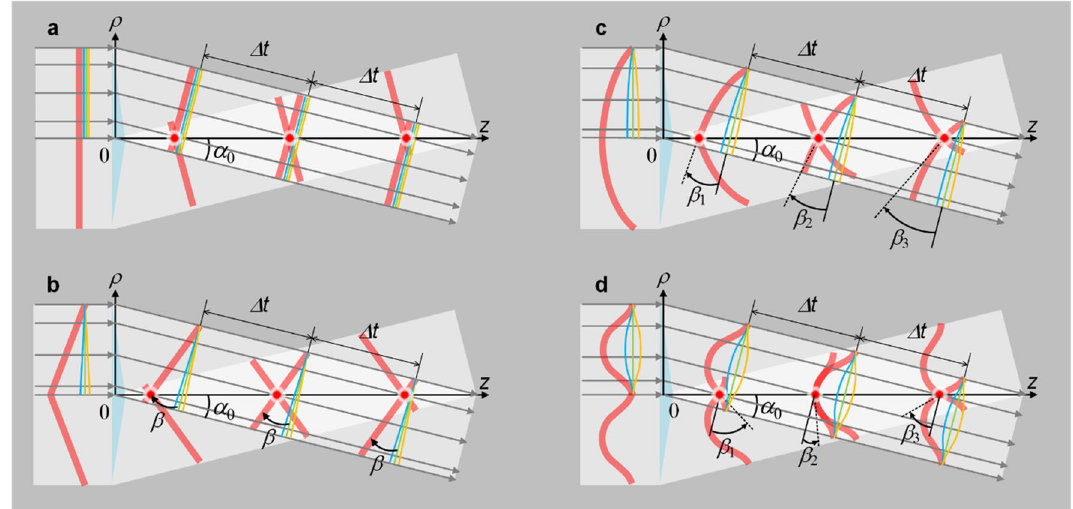
Figure 3. Influence of pulse-front deformation of input pulsed beam on instantaneous group-velocity of produced propagation-invariant optical wave-packet. Because distribution is axisymmetric about z -axis, only upper input half beam for conical superposition is illustrated. Red thick curve denotes pulse-front; blue, green and yellow curves denote wave-fronts of the highest, center and lowest frequencies, and that of center frequency is defined as phase-front; α 0 is half conical-angle for phase-front; β is pulse-front tilt angle with respect to phase- front; and ∆ t is a fixed time gap during propagation. ( a ) Without pulse-front deformation, instantaneous group- velocity is only determined by α 0 . With pulse-front deformation, instantaneous group-velocity is determined by both α 0 and β , and β is constant for ( b ) a tilted pulse-front, linearly increases for ( c ) a spherical pulse-front, and periodically varies for ( d ) a cosine-function-like pulse-front. Figure generated by Microsoft® Visio® 2013 50